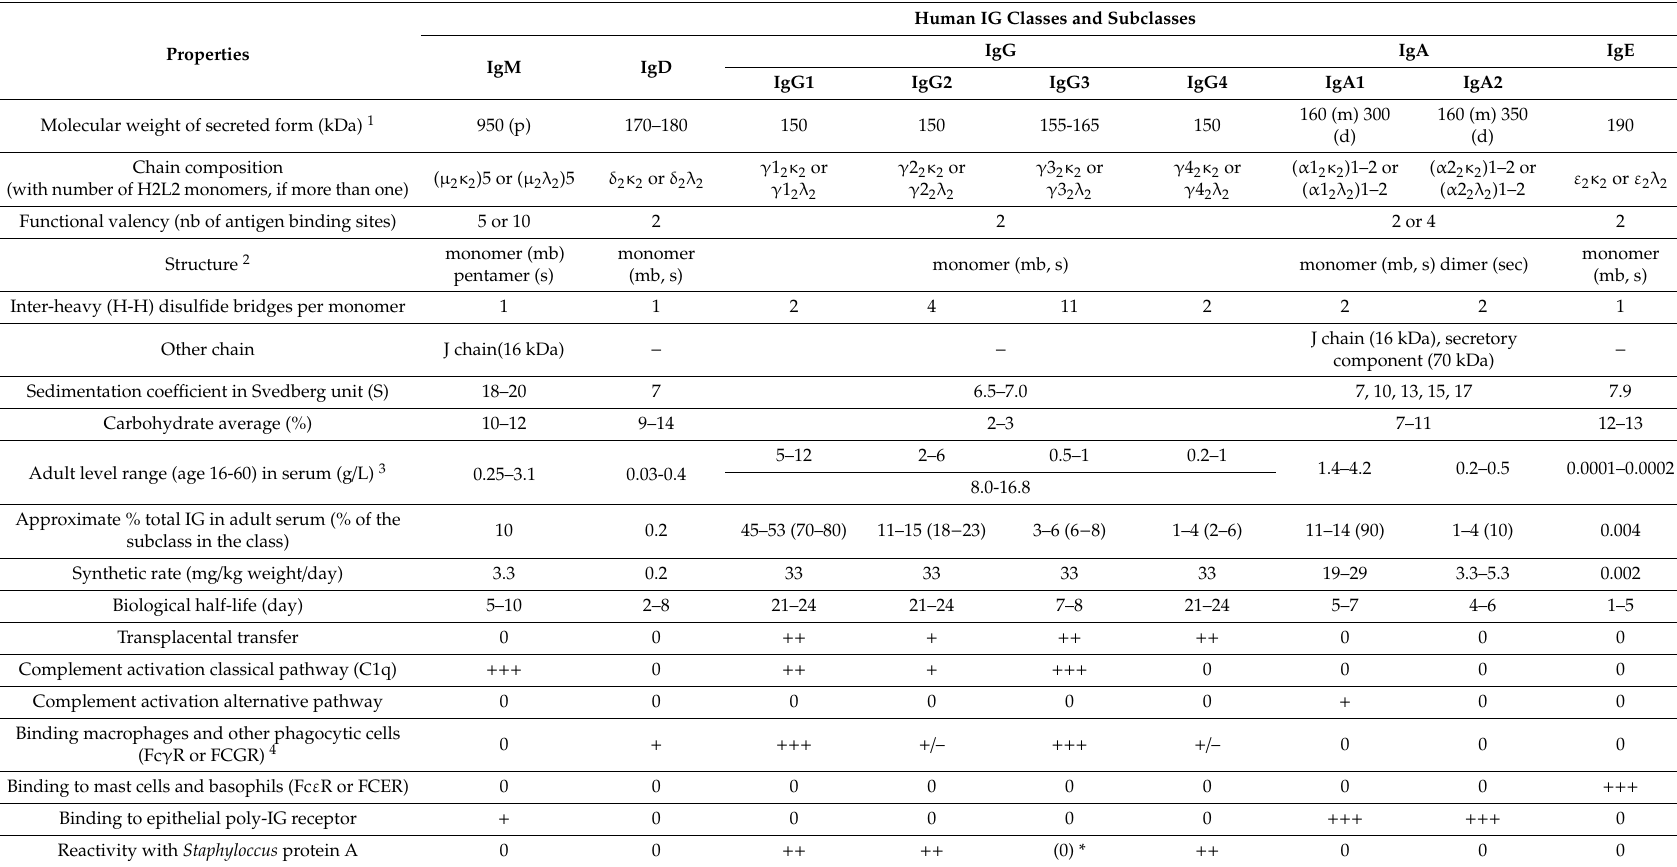
Table 2. Structural and biological properties of human immunoglobulins